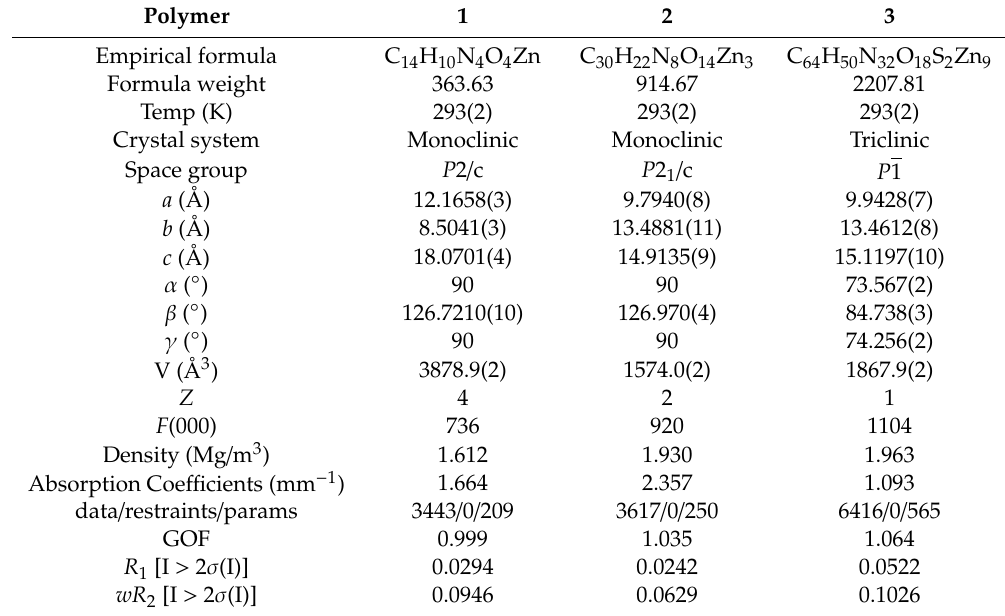
Table 1. Crystal data and structure refinement parameters for the three polymers.